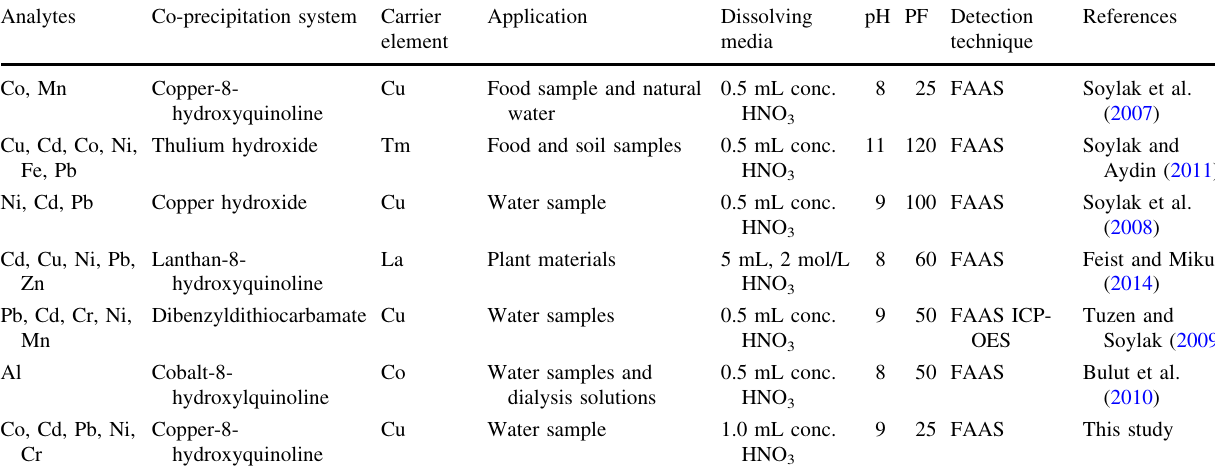
Table 4 Comparison of this study with data from other studies on co-precipitation of heavy metal ions Analytes